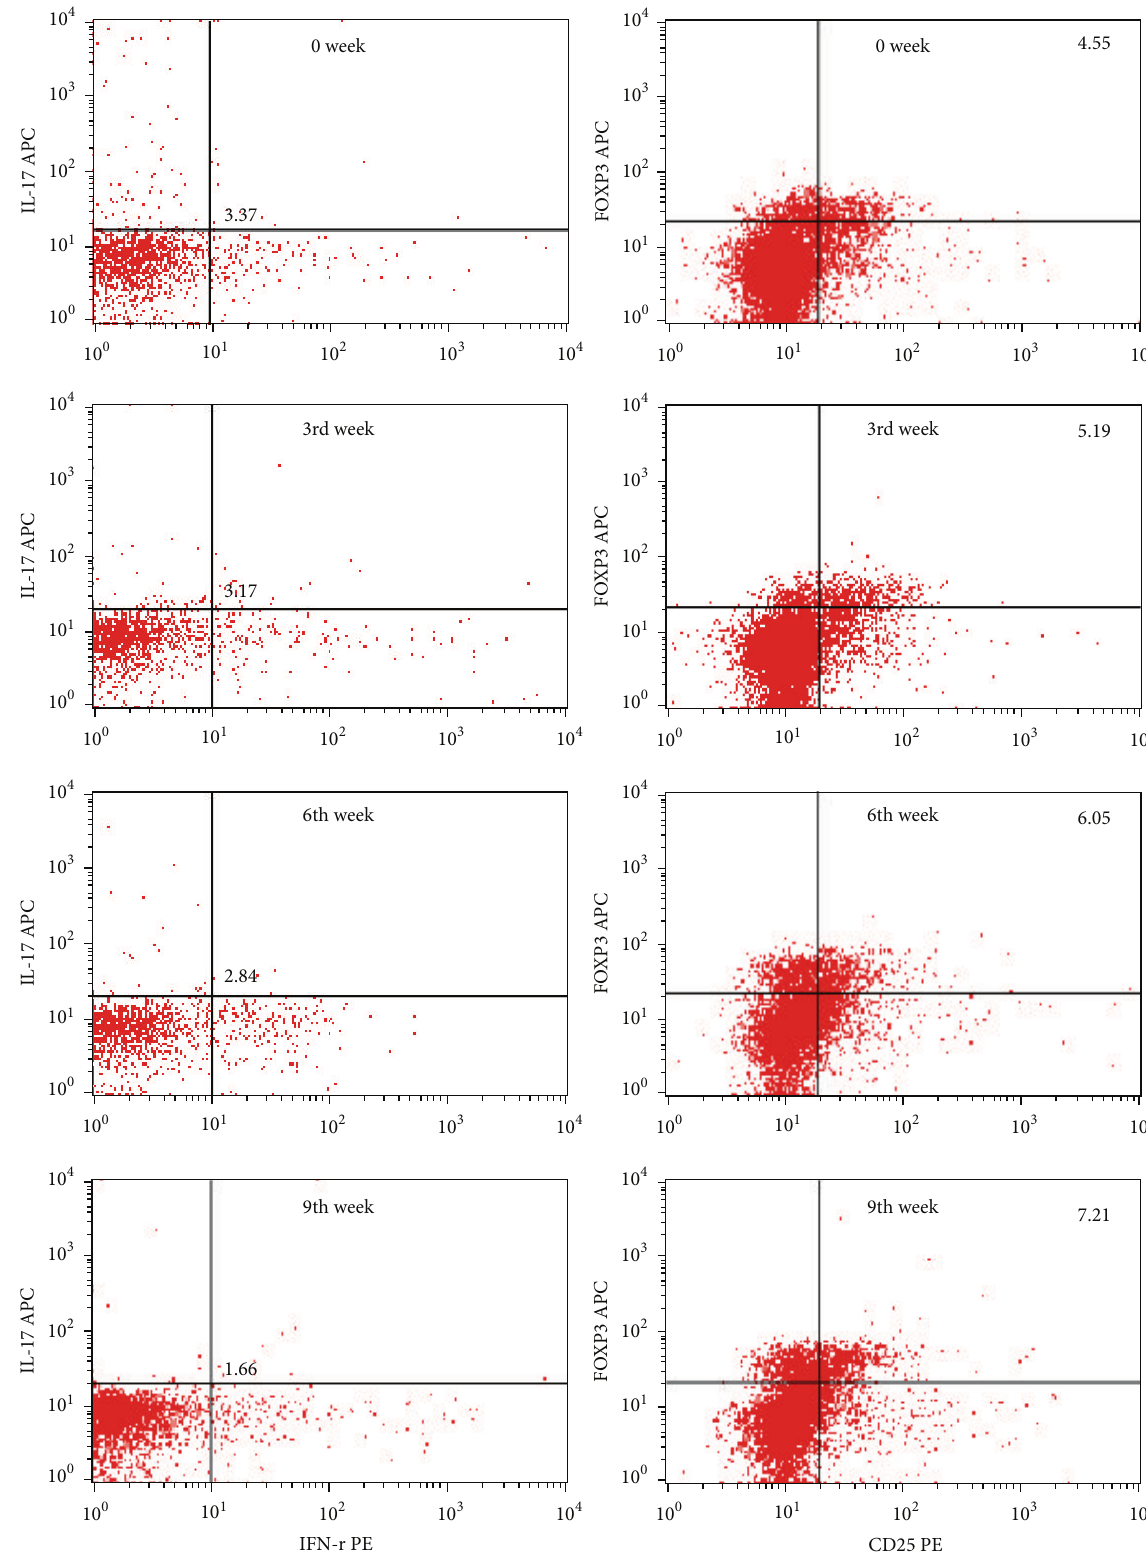
Figure7:FlowcytometryimageofTh17(IL-17A + )andTreg(CD25 + FOXP3 + )fromMTXcombinedwithCTX-treatedmice.Datarepresented one of at least three independent experiments with 5